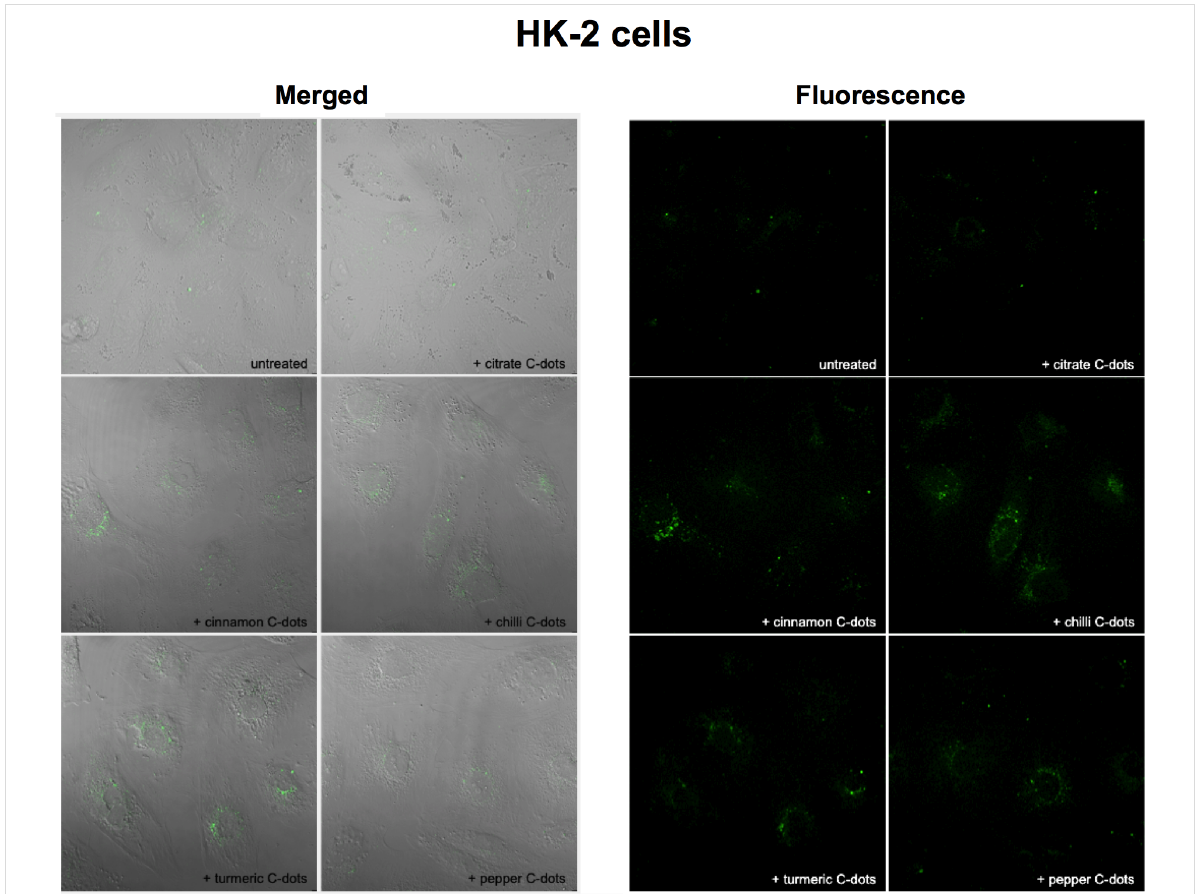
Figure 10: Merged transmission and fluorescence (left) and fluorescence (right) imaging of HK-2 cells after 24 h of incubation with no C-dots (untreated) and with 1 mg·mL − 1 of citrate, cinnamon, red chilli, turmeric and black pepper C-dots. Images were collected using a Zeiss LSM780 confocal microscope (40× objective), using a 405 nm laser and collecting the emitted fluorescence in the green area.